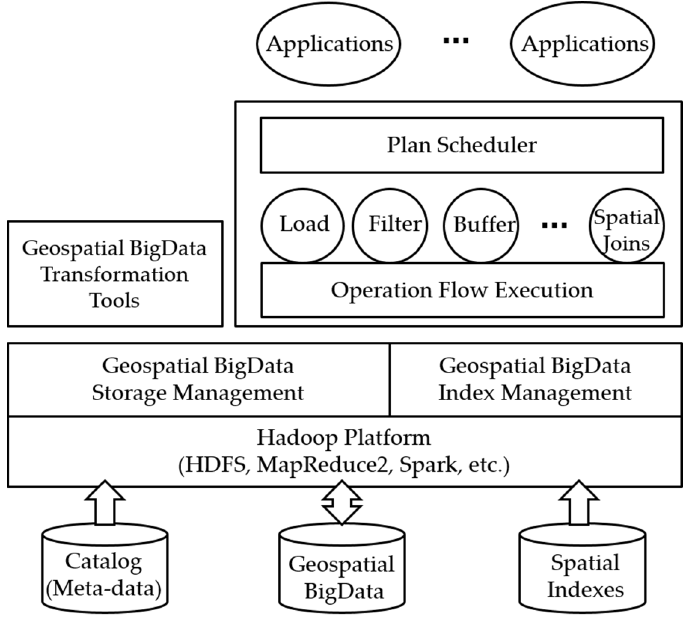
Figure 1. Overall structure of Marmot.